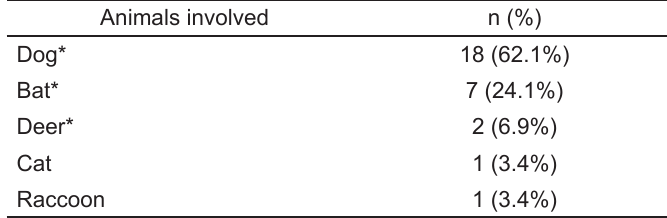
Table 3. Animals involved in rabies bites.